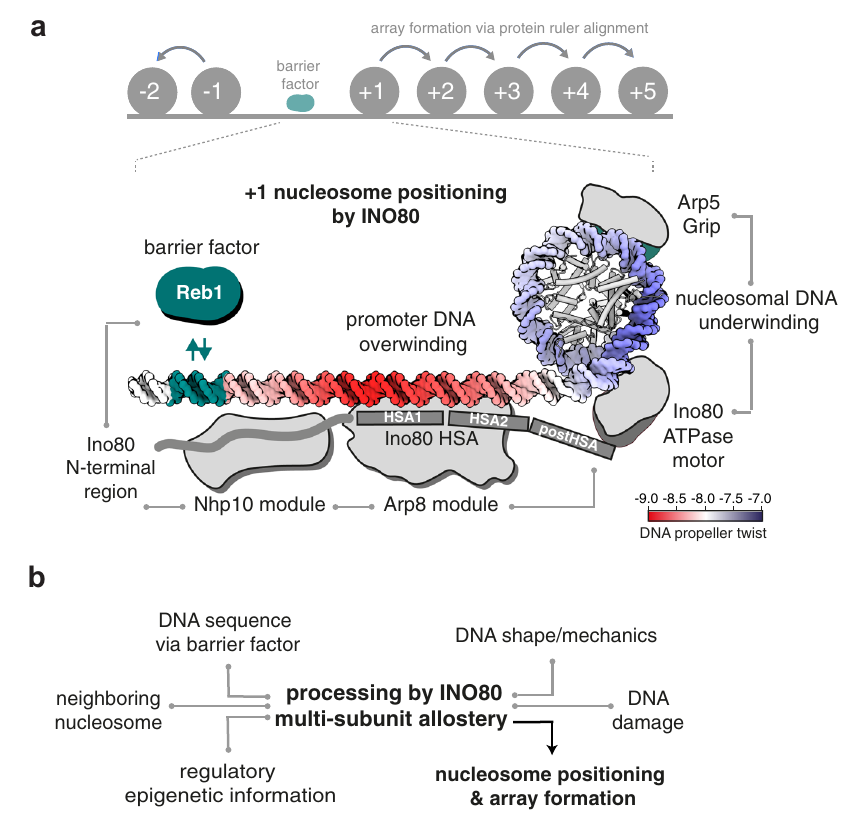
Fig. 9 Model of + 1 nucleosome positioning by INO80. a INO80 synergistically processes genomic information derived from DNA shape/mechanics as well as DNA sequence motifs bound by GRFs, like Reb1, into + 1 nucleosome positioning. Structural 44,47 , biochemical 48 , and ChIP-exo mapping 41 data suggest a binding architecture of INO80 at + 1 nucleosomes that is fully consistent with the identi fi ed positioning information and mechanism. Promoter DNA overwinding and nucleosomal DNA underwinding is derived from the direction of DNA translocation by the Snf2-type ATPase of INO80 43 . Allosteric communication is indicated by gray lines. b Signal readout, integration, and processing by multi-subunit allostery within INO80 lead to nucleosome positioning and array formation. Epigenetic information such as histone marks are expected to provide an additional layer of regulatory input, e.g., in response to the physiological state of the